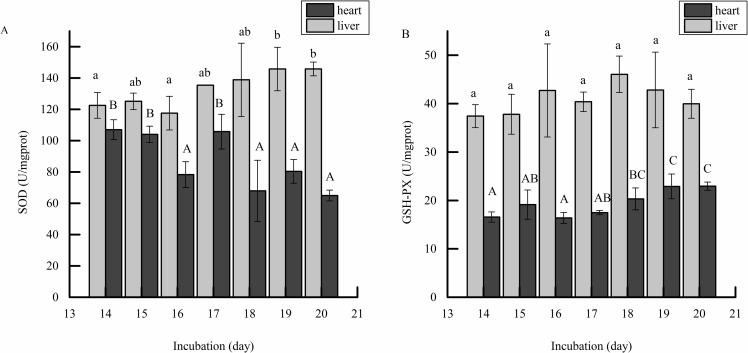
Effect of incubation day on SOD and GSH-PX activity in embryonic liver and heart.Note: The SOD activity (A) and GSH-PX (B) of heart and liver tissues were determined at days 14 to 20. The value of each fraction was the mean± standard deviation (n = 3), different letters (a, b) above columns indicate significant differences (p<0.05) in liver tissues, different letters (A, B) above columns indicate significant differences (p<0.05) in heart tissues.